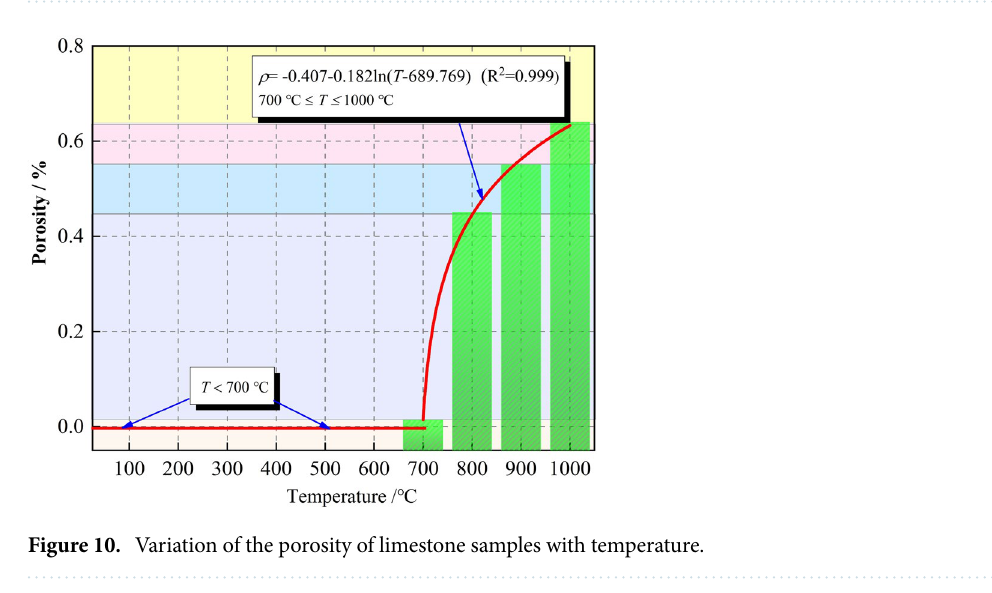
Figure 9. The layer-by-layer porosity distribution of limestone samples after high-temperature treatment.